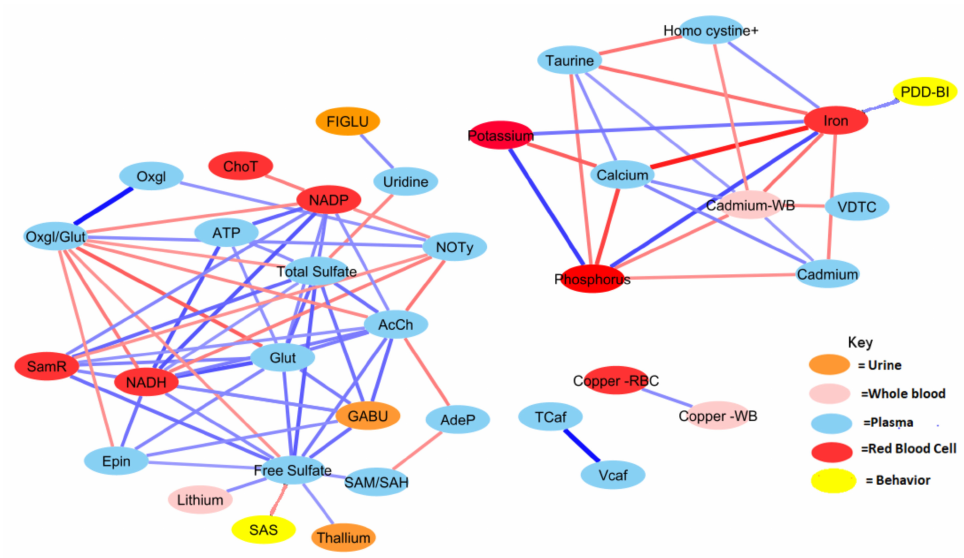
Figure 4. Correlation network between significant biochemical and xenobiotic compounds in the ASD cohort (strength of the correlation is visualized by the line thickness, positive correlations are in blue and negative correlations are in red). In order for a relationship to be deemed significant, the correlation coefficient had to be greater than 0.35, FDR less than 0.10, and the p -value less than 0.05. In total, 212 significant correlations (106 pairs) were observed. Acetylcholine had the greatest number of relationships, with 14 significant relationships (see Table A2 for